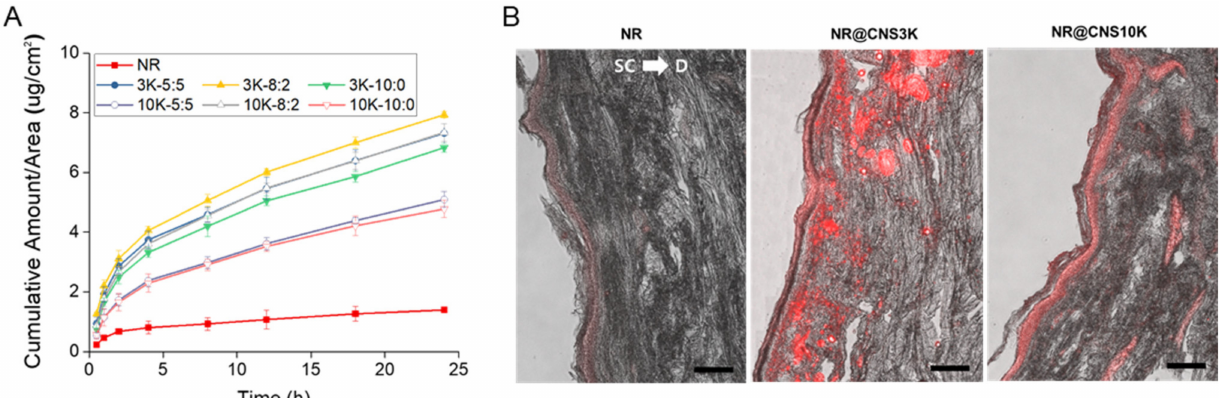
Figure 6. ( A ) In vitro skin permeation of Nile red (NR) through human cadaver skin at several time points over 24 h, with CNS3Ks and CNS10Ks (at ratios of 5:5, 8:2, and 10:0). ( B ) Fluorescence images showing the permeation and distribution of NR in skin samples using CNS at an 8:2 ratio after a 24 h in vitro skin permeation test. The scale bar indicates 100 µ m. (SC: stratum corneum and D: